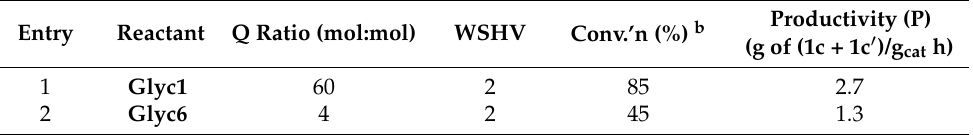
Table 3. The acetalization of Glyc1 and Glyc5 with 2-butanone catalyzed by AlF 3 ·3H 2 O a .